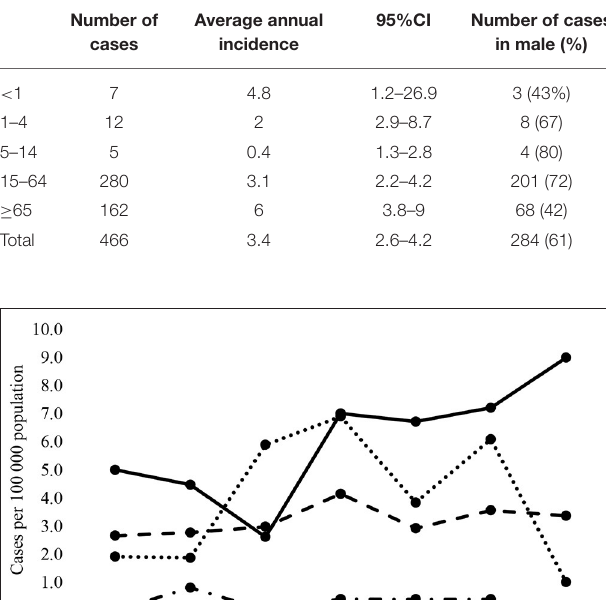
TABLE 1 | S. pneumoniae serotype groups according vaccine constituent serotypes.